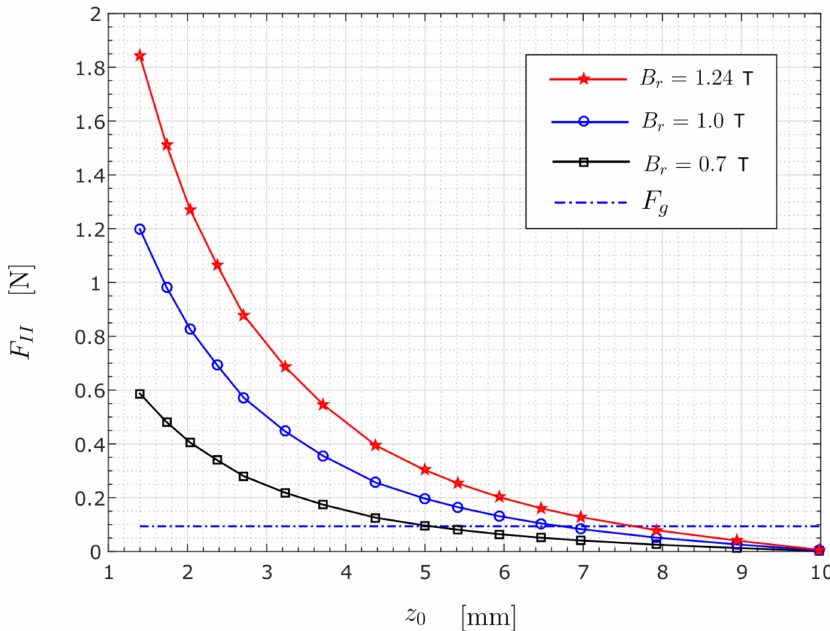
Figure 18. The calculated curves of magnetic levitation force F II for three different values of the PM’s remanence, i.e., B r = 0.7 T, B r = 1.0 T, and B r = 1.24 T, respectively. The force F II was calculated by the SIM. The stable levitation height z 0 appears where the individual curve F II in-tersects the gravitational force line F g .